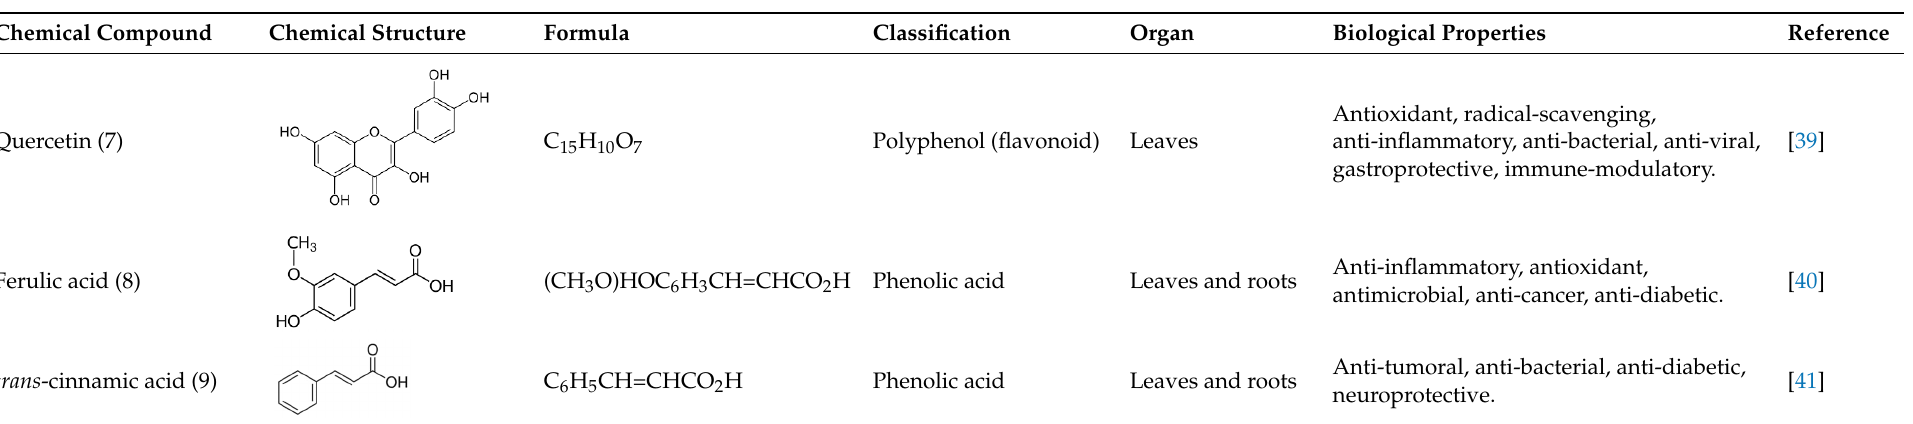
Anti-tumoral, anti-bacterial, anti-diabetic, Leaves and roots neuroprotective.